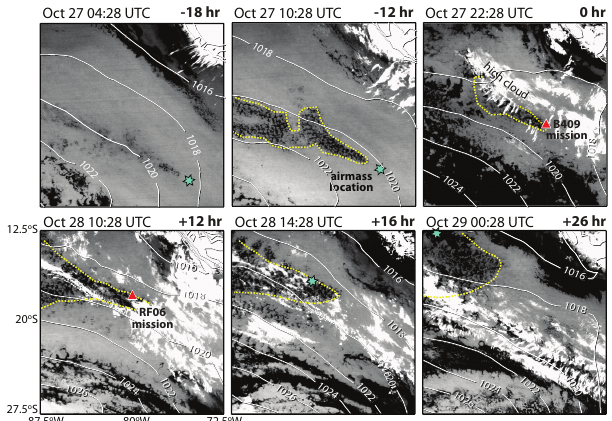
Fig. 2. Sequence of thermal infrared satellite images from GOES-10 for a 44h period from 04:26UTC on 27 October (18h before flight B409) to 00:28UTC on 29 October 2008 (12h after the end of the sampling on flight RF06). The blue stars (or red triangles for times of missions) show the location of the advected airmass over the period determined using forward/backward Hysplit trajectories initialized at 00:00UTC 28 October. White contours show sea level pressure contours, while yellow dashed line delineates region of open cells. Although not discussed further in this manuscript, the yellow boat indicates the location of the NOAA R/V Ronald H Brown which sampled the same pocket of open cells but at a more westward location near 20 ◦ S, 85 ◦ during the first half of 27